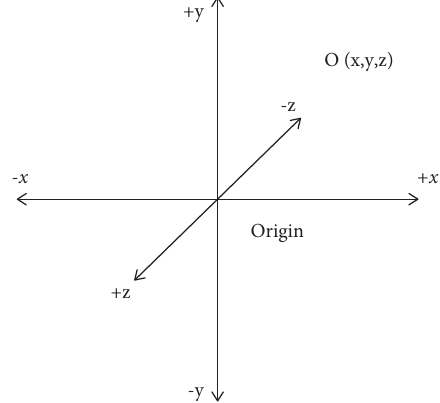
Figure 3: Cartesian space coordinate system diagram.